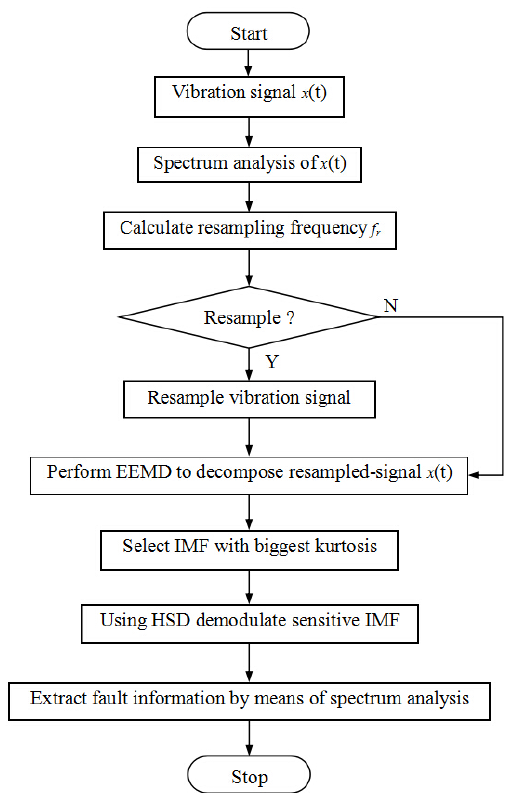
Figure 4. The flow chart of the proposed method. HSD, Hilbert square demodulation.